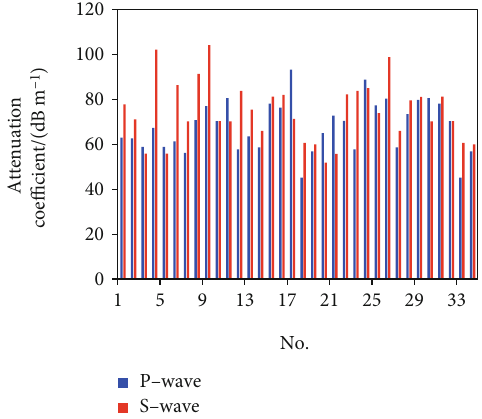
Figure 6: The attenuation coe ffi cient of samples.